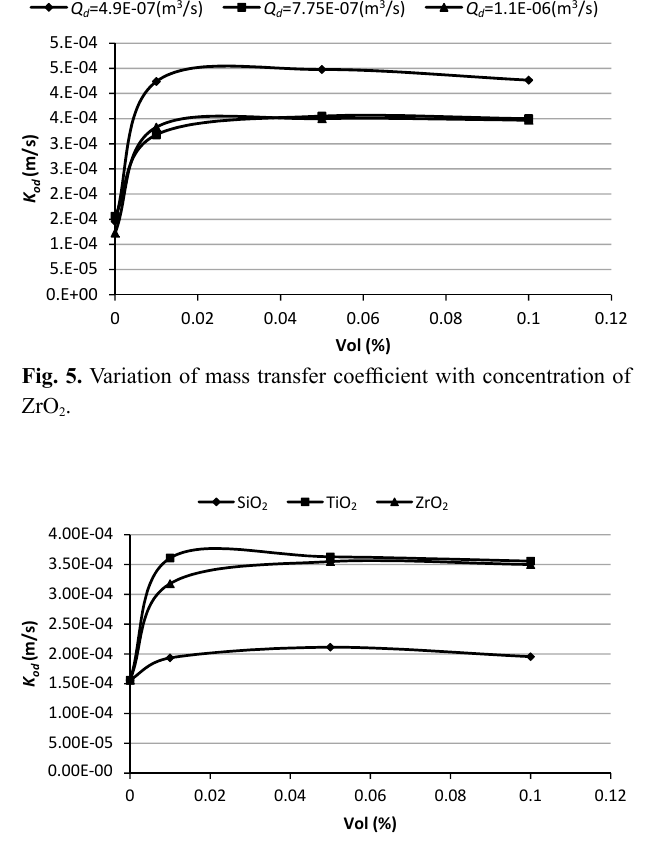
Fig. 6. Variation of mass transfer coefficient with concentration for various nanoparticles in Q d = 7.75E-07 (m 3 /s).